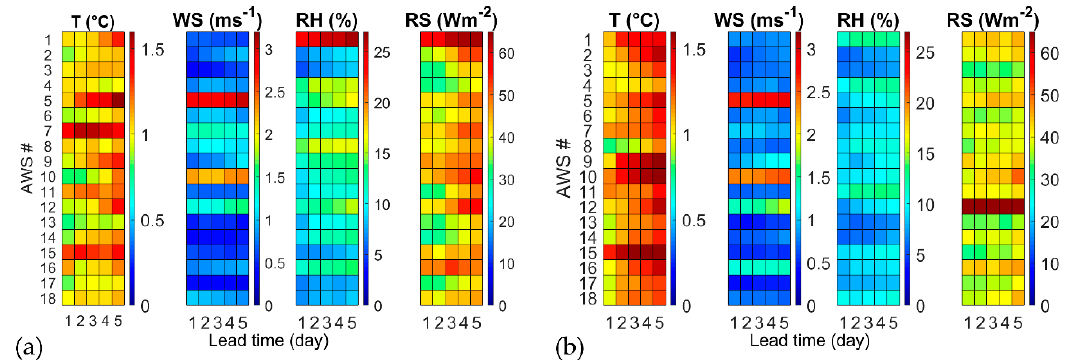
Figure 3. Root mean squared error (RMSE) of forecasted daily weather variables at the 18 automatic weather stations (AWS) sites for lead times from 1 to 5 days in the period: ( a ) June–September 2014; ( b ) June–September 2015.